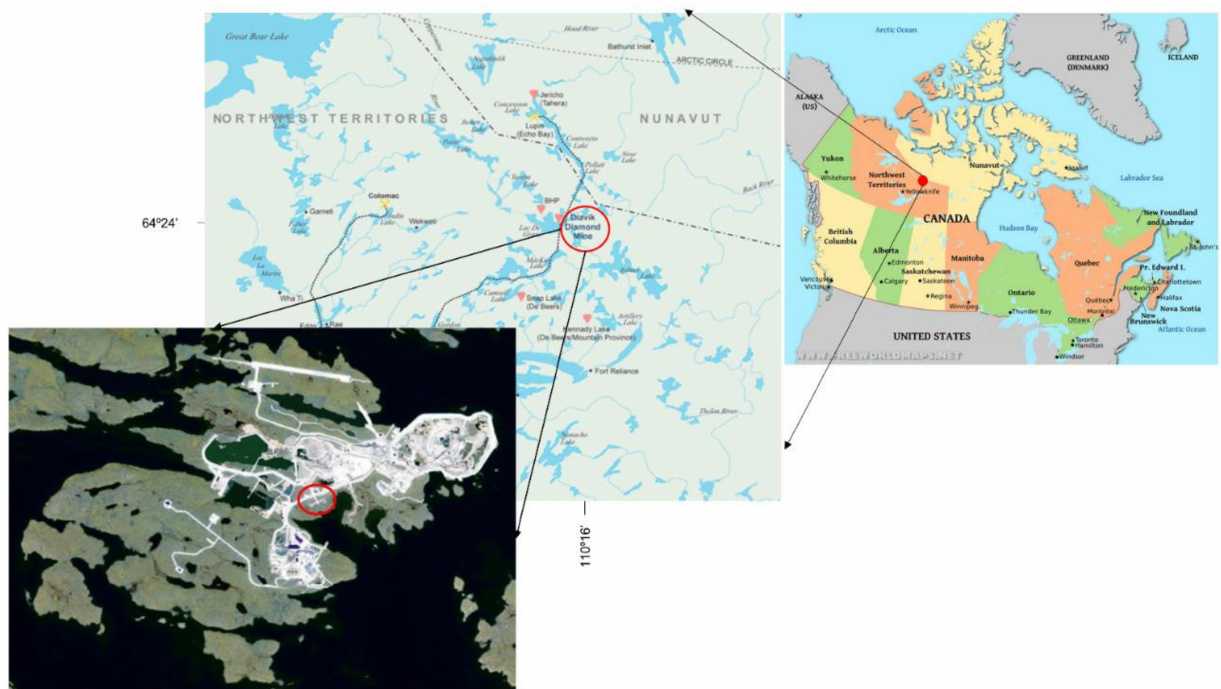
Figure 1. Location of research sites. The red circle shows the actual research site